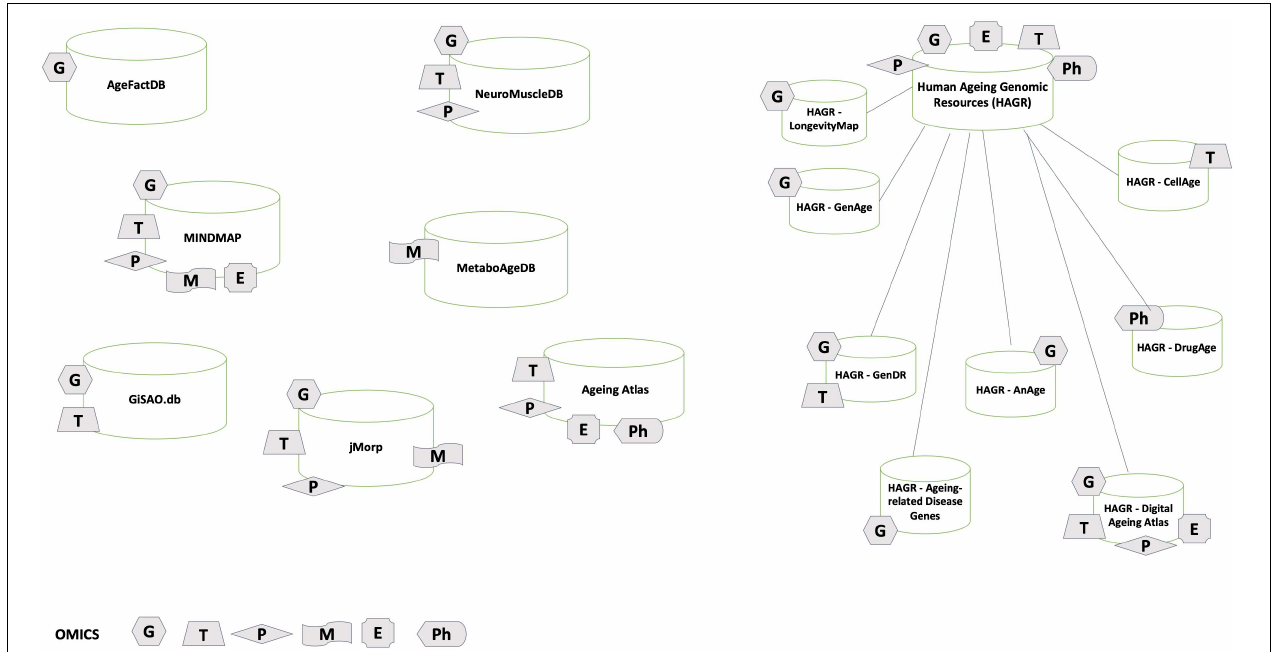
FIGURE 1 | Omics aging databases. General overview of the main aging research databases described in the review: we have annotated each database with the omics data type it provides. G stands for genomics; T for transcriptomics; P for proteomics; M for metabolomics; E for epigenomics; Ph for